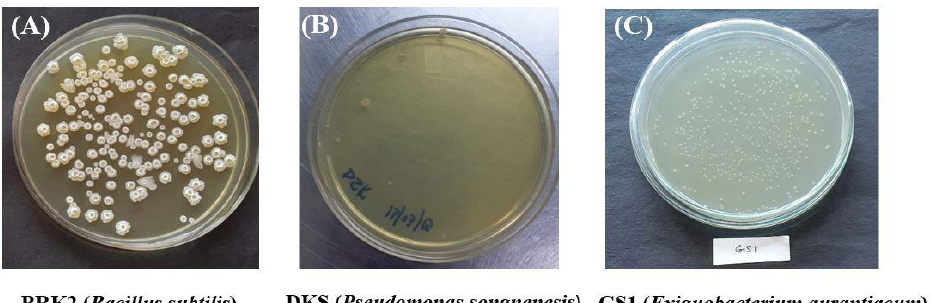
Figure 9. Most dominant bacterial strains Bacillus subtilis ( A ), Pseudomonas songnenesis ( B ), and Exiguobacterium aurantiacum ( C ) isolated from three selected sampling stations (BRK, DKS, and GS) in the HRE.